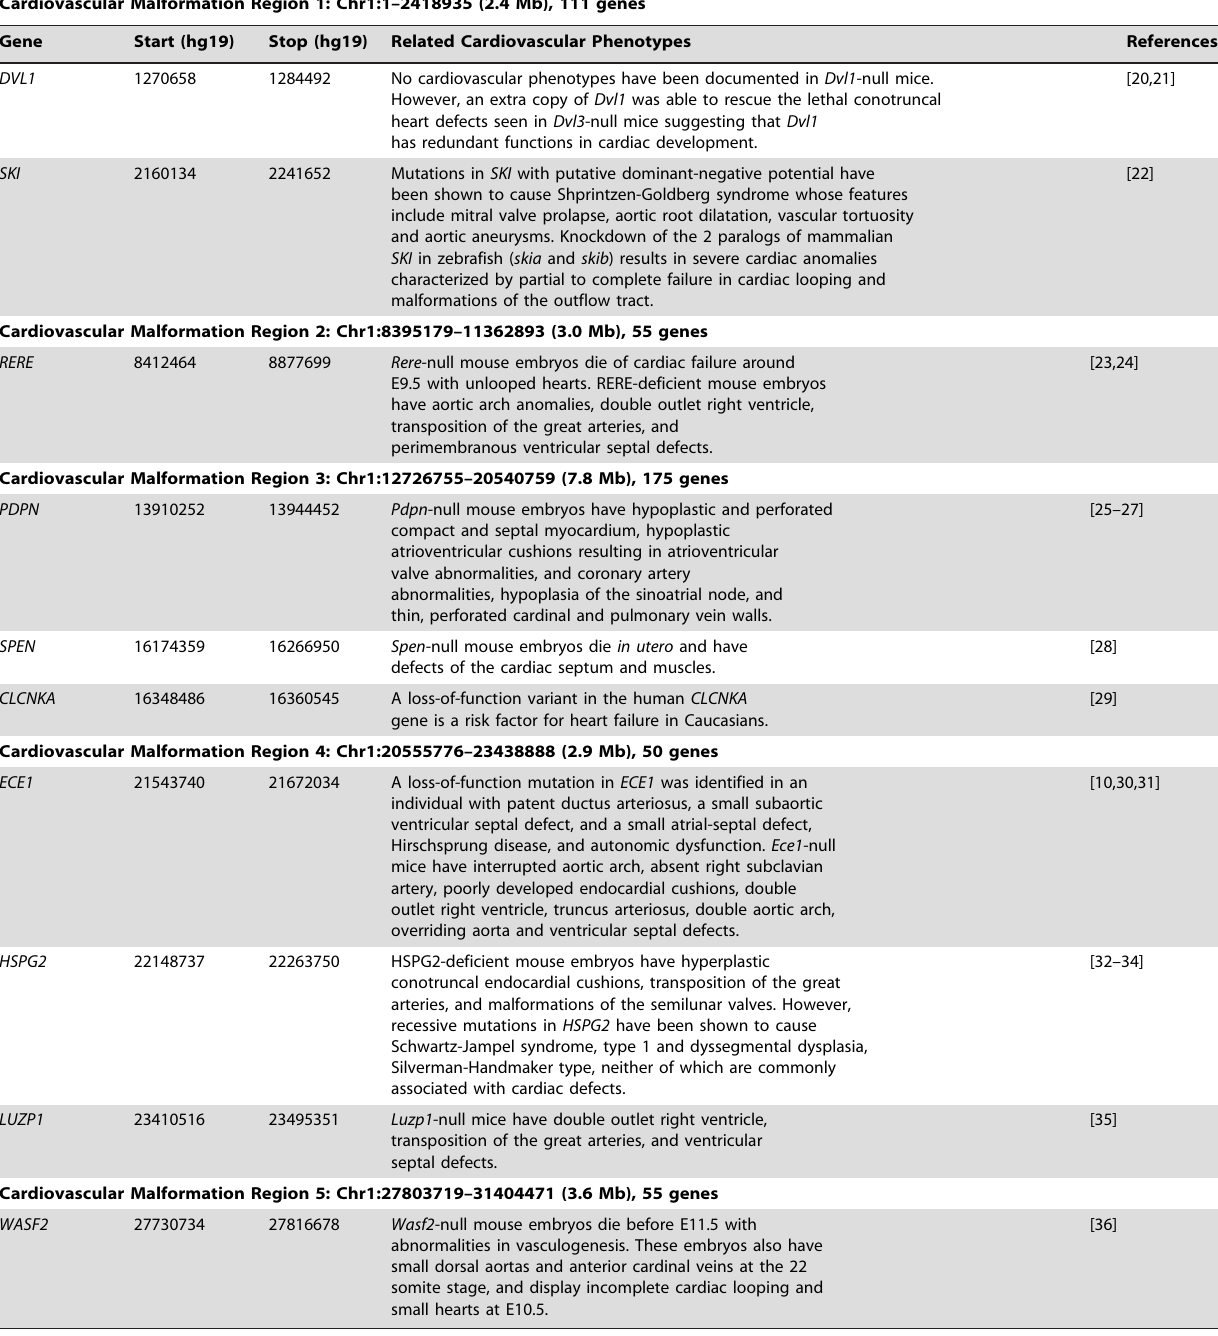
Table 7. Cardiac-related genes within cardiovascular malformation critical